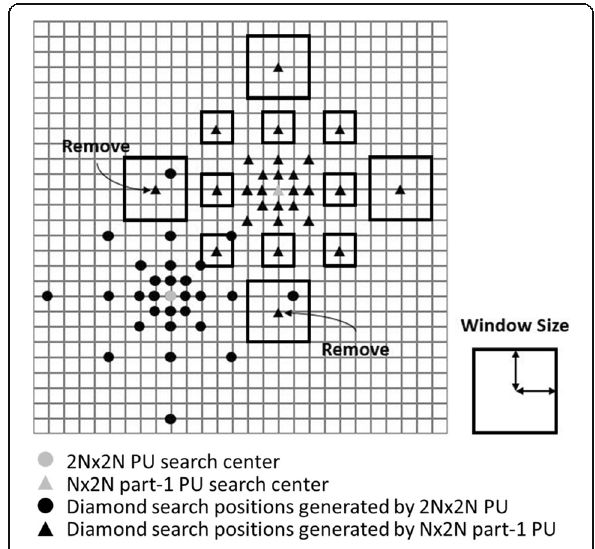
Fig. 10 Search point reduction scheme for the diamond search